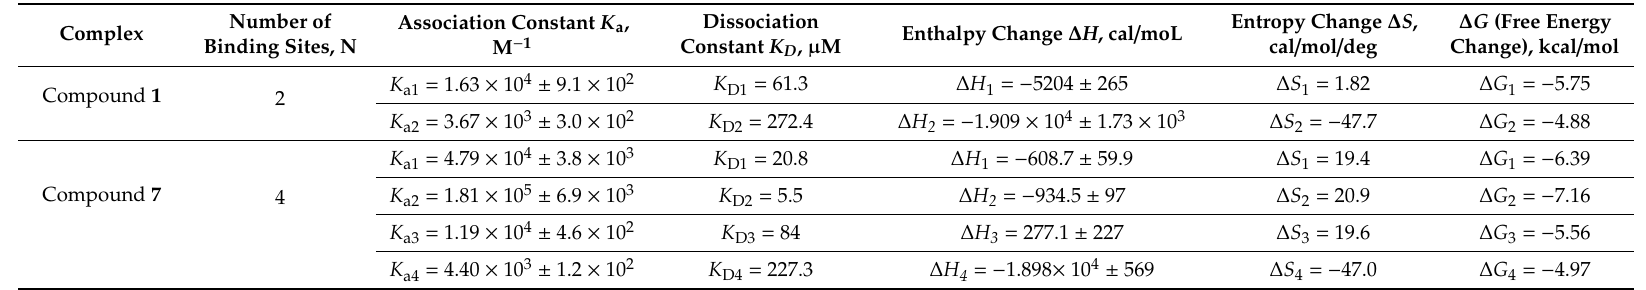
Table 2. Thermodynamic parameters obtained from calorimetric titrations of Compounds 1 and 7 with